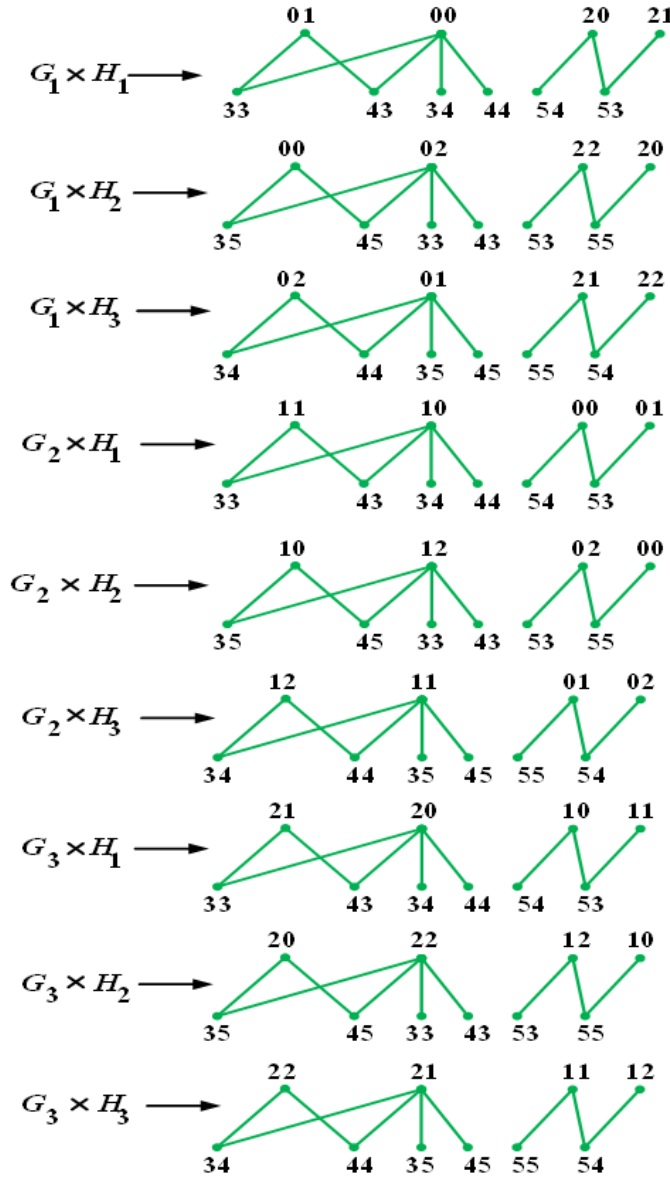
Figure 7. An edge decomposition of C 18,9 by ( K 1,2 ∪ K 2 ) (cid:126) P 4